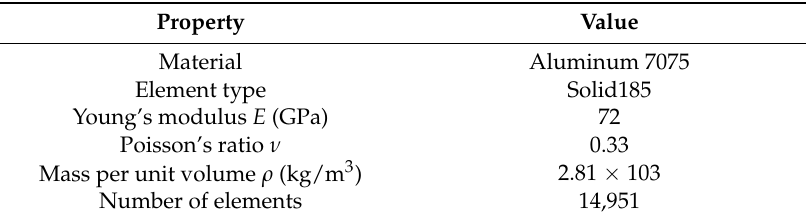
Table 2. Properties of FE model in